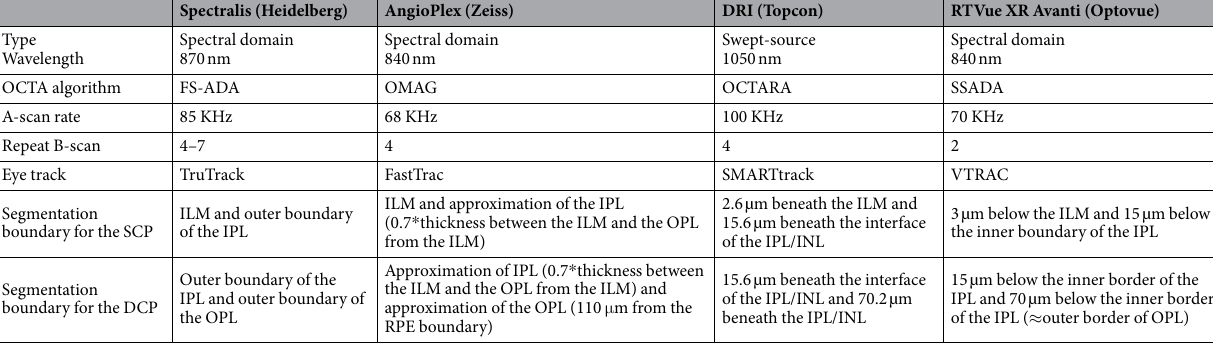
Table 1. OCTA Instruments. DCP = deep capillary plexus; FS-ADA = full-spectrum amplitude decorrelation